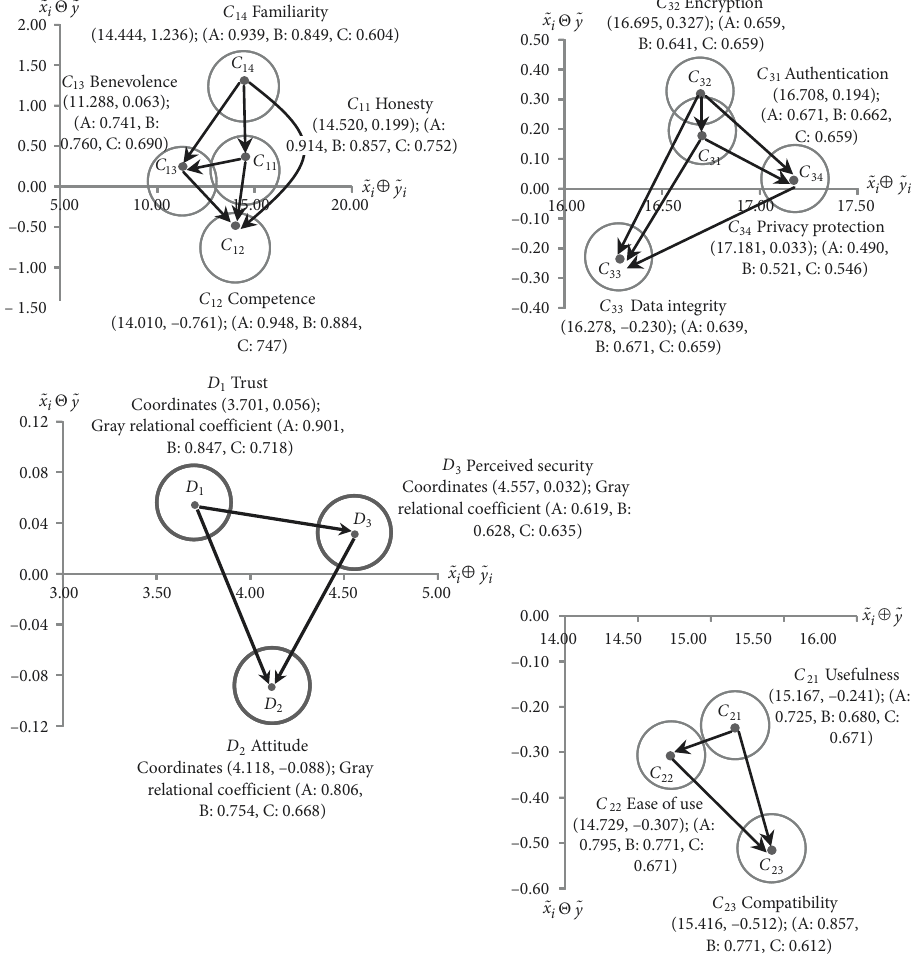
Figure 4. Fuzzy influential network relationship map for systematic improvement in three